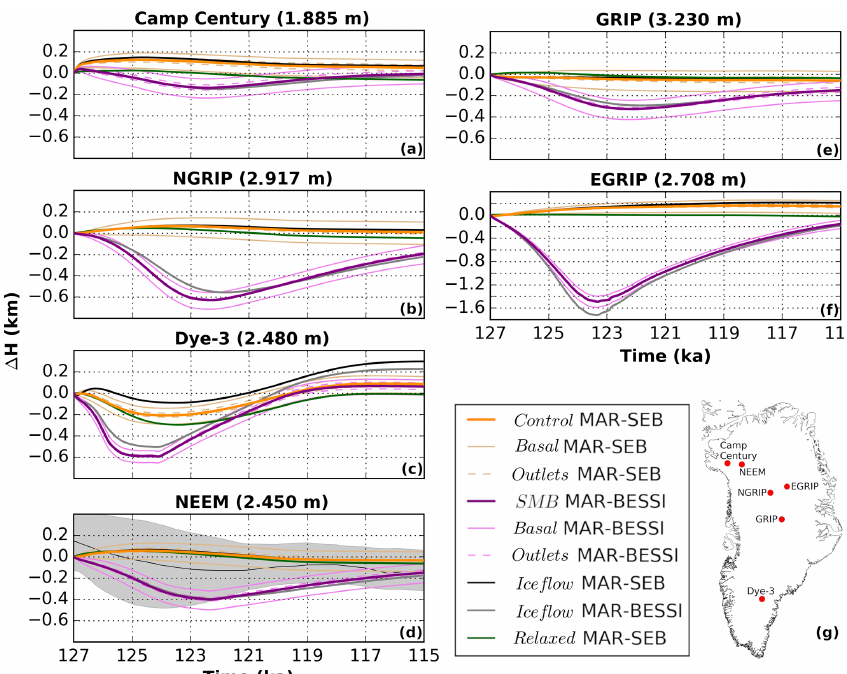
Figure 5. Ice surface evolution at Greenland ice core locations for the control , SMB , basal , outlets , ice flow , and relaxed experiments – Camp Century, NEEM, NGRIP, GRIP, and Dye-3 are shown on the same scale; EGRIP is shown on a different scale. Same color coding as in Figs. 1 and 2. Surface elevation reconstructions from total gas content at NEEM are indicated with gray shading. Note that the 2-D experiments are plotted in the background and therefore hardly visible in some cases, particularly at NEEM.